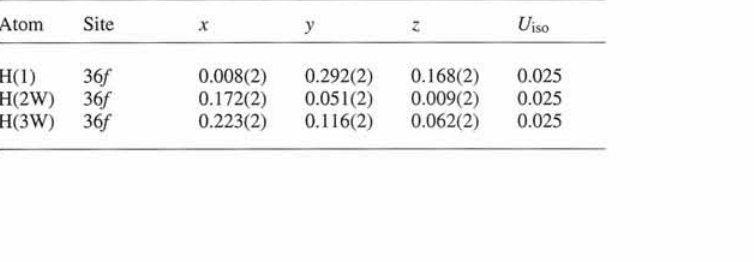
Table 2. Atomic coordinates and displacement parameters (in